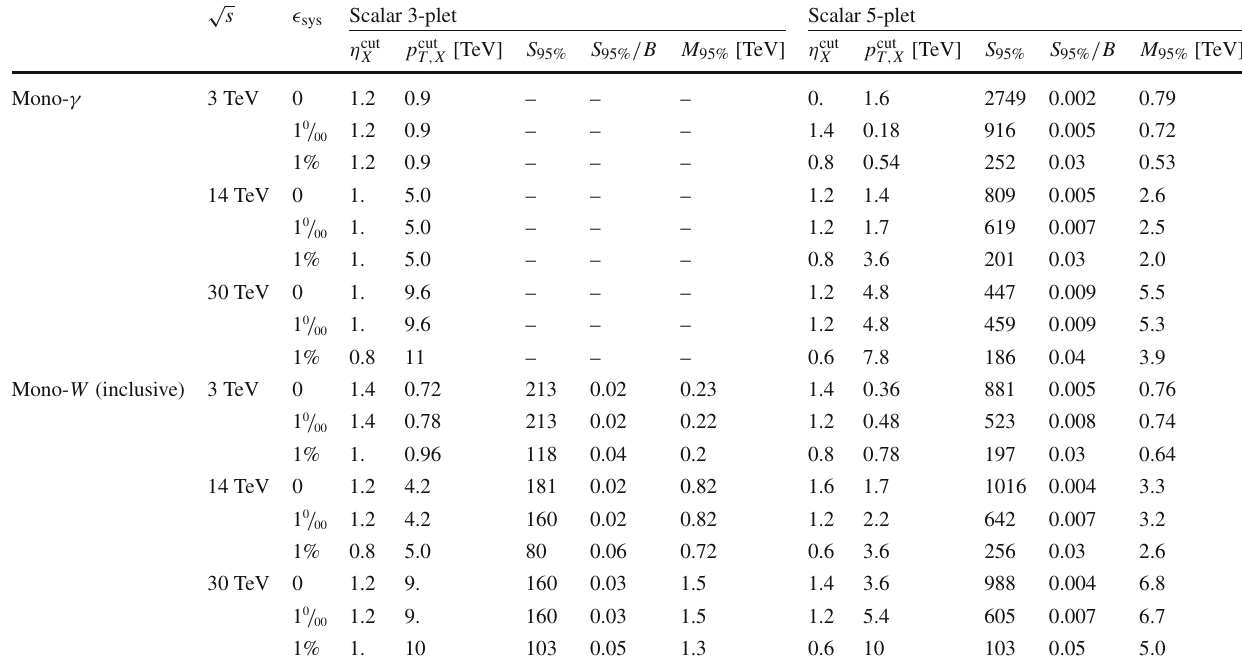
Table 3 Same as Table 2 but for scalar 3-plet and 5-plet. A ‘–’ indicates that no 95% C.L. exclusion is possible